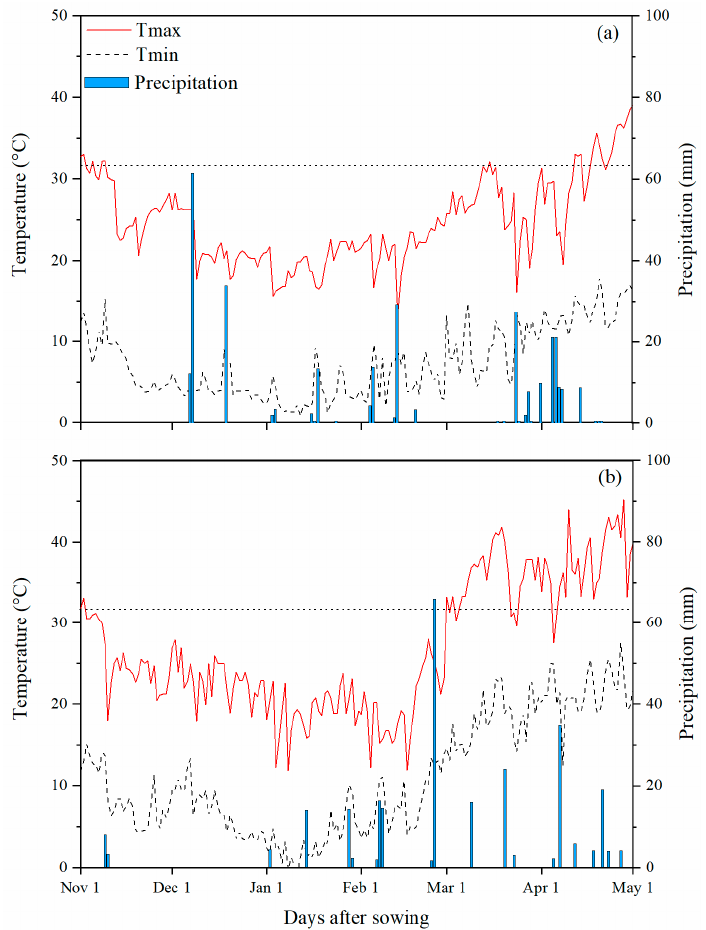
Figure 1. Weather data measured during wheat crop growing season for two years (( a ); 2013–2014 and ( b ); 2014–2015) at Koont research farm. The dotted line represents the temperature threshold (>32 ◦ C). Table 1. Agronomic traits, water use efficiency, and N use efficiencies of the wheat crop during 2013–2015.